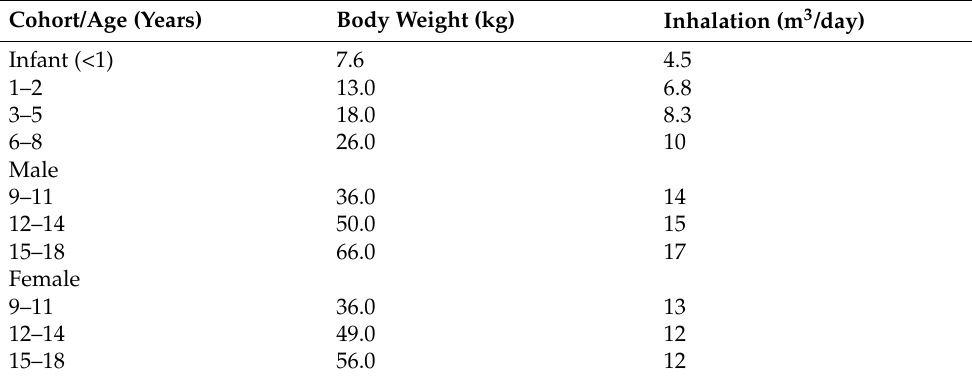
Table 2. Body weight and inhalation in the different age groups of